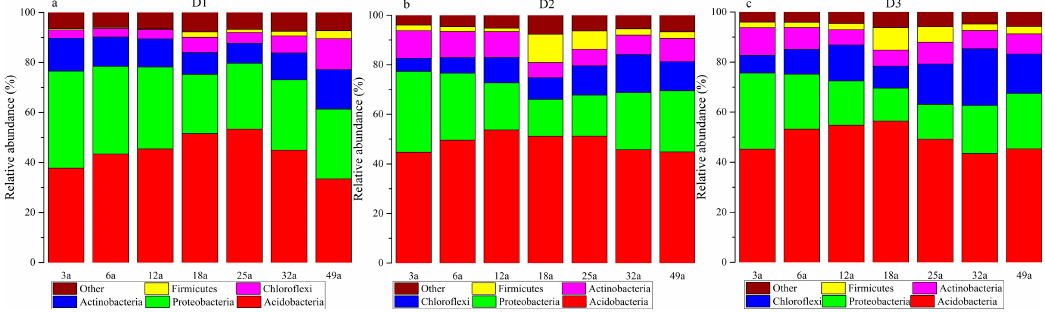
Figure 4. The compositions of bacterial at the phylum level in different stand age samples. ( a ) Bacterial community at the phylum level in D1, ( b ) bacterial community at the phylum level in D2, ( c ) bacterial community at the phylum level in D3.